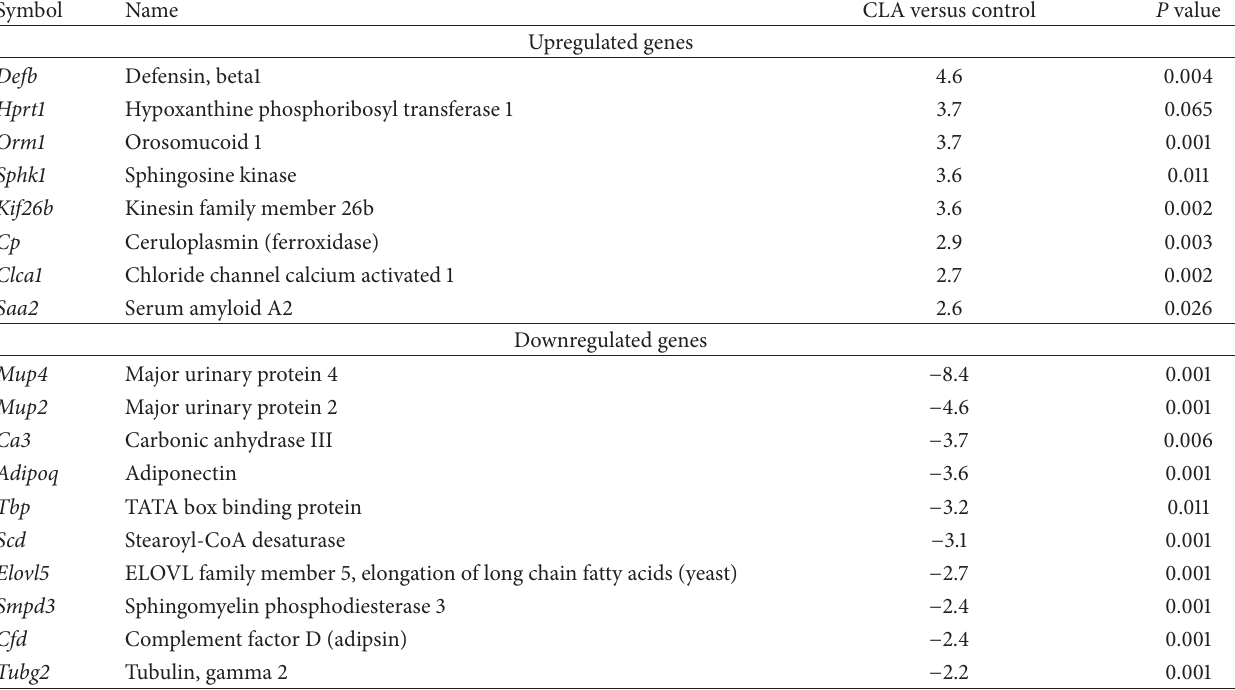
Table 4: Fold change in expression among the most up- and downregulated DEG in mammary tissue of lactating mice fed trans -10, cis -12- CLA.